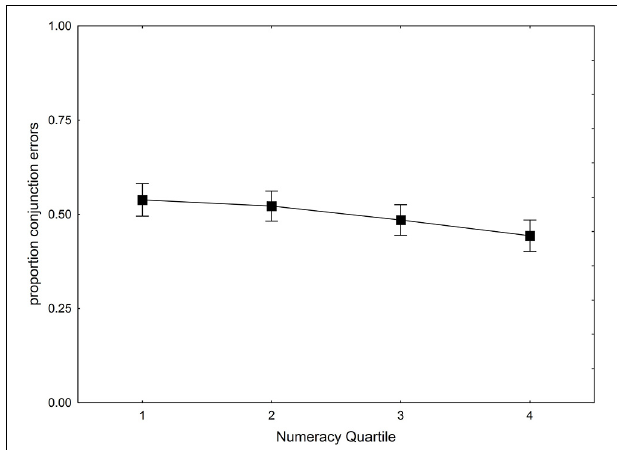
FIGURE 5 | Proportion of conjunction errors plotted as function of Numeracy Quartile. Square symbols depict means adjusted for the effects of potentially confounding variables (gender, age, IQ, and proportion of correct